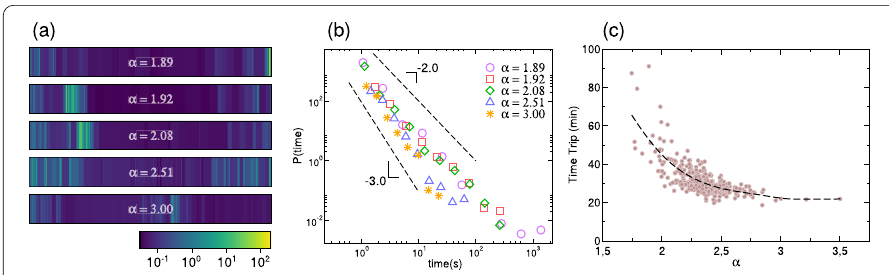
Figure 5 Characterization of the distribution times of bus route 650I . ( a ) The time series ( (cid:2) t ∗ ) for five different trips of the bus route 650I shown in a logarithmic color scale. The largest values of (cid:2) t ∗ are approximately concentrated in the same regions. ( b ) The distribution of the values (cid:2) t ∗ for the same five trips are illustrated in logarithmic scale. We performed a power–law fitting for each distribution. We see that each trip has a different value for the power–law exponent α . The dashed lines are a visual guide with slope –3.0 and –2.0. In ( c ) we have the relation between the α exponent and the total time that the bus used to finish the scheduled trajectory. Each point represents a trip of line 650I and the dashed line represents the average behavior obtained from the Nadaraya–Watson regression. The large values of time trips for low values of α corroborates the correlation between Gini and time delay D (Fig. 4(b)), since distributions with α → 2.0 must have Gini close to